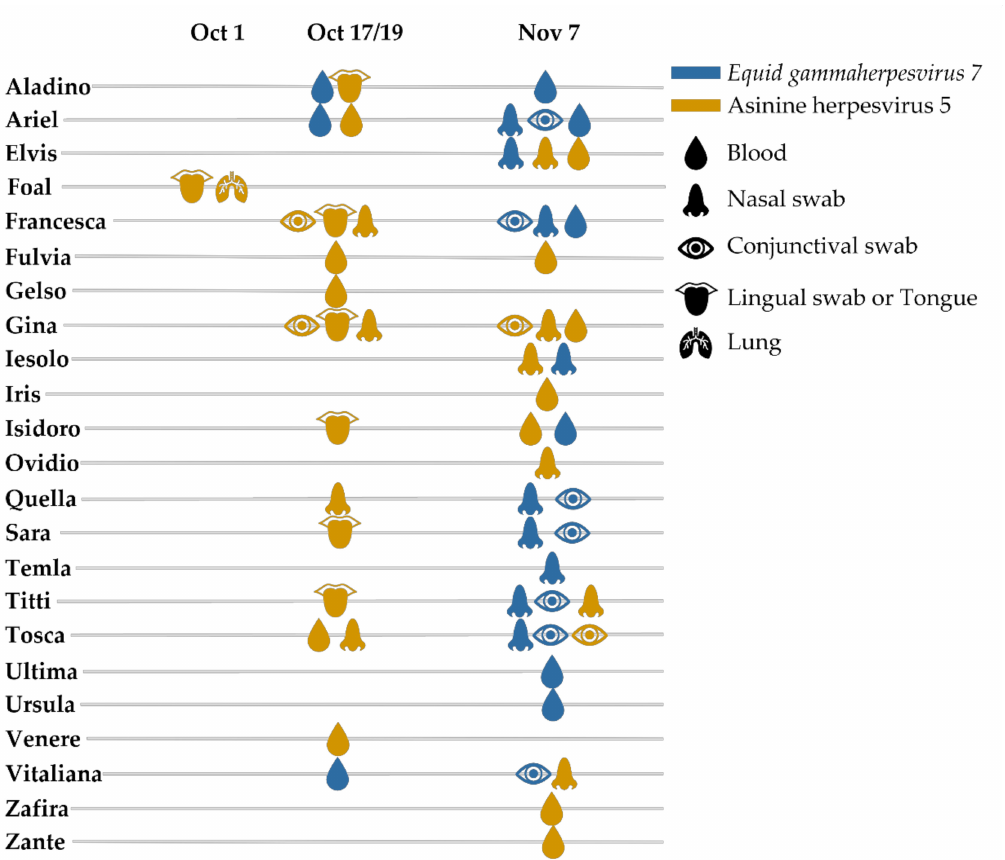
Figure 2. Timeline showing virus genotyping results. The results of phylogenetic-based typing of sequences obtained in this study from samples collected at three different timepoints are shown for each of the 23 positive donkeys. Sample type (blood–EDTA, tissues, or swabs) is depicted by an image that is coloured depending on the outcome of the analysis, as indicated by the legend on the